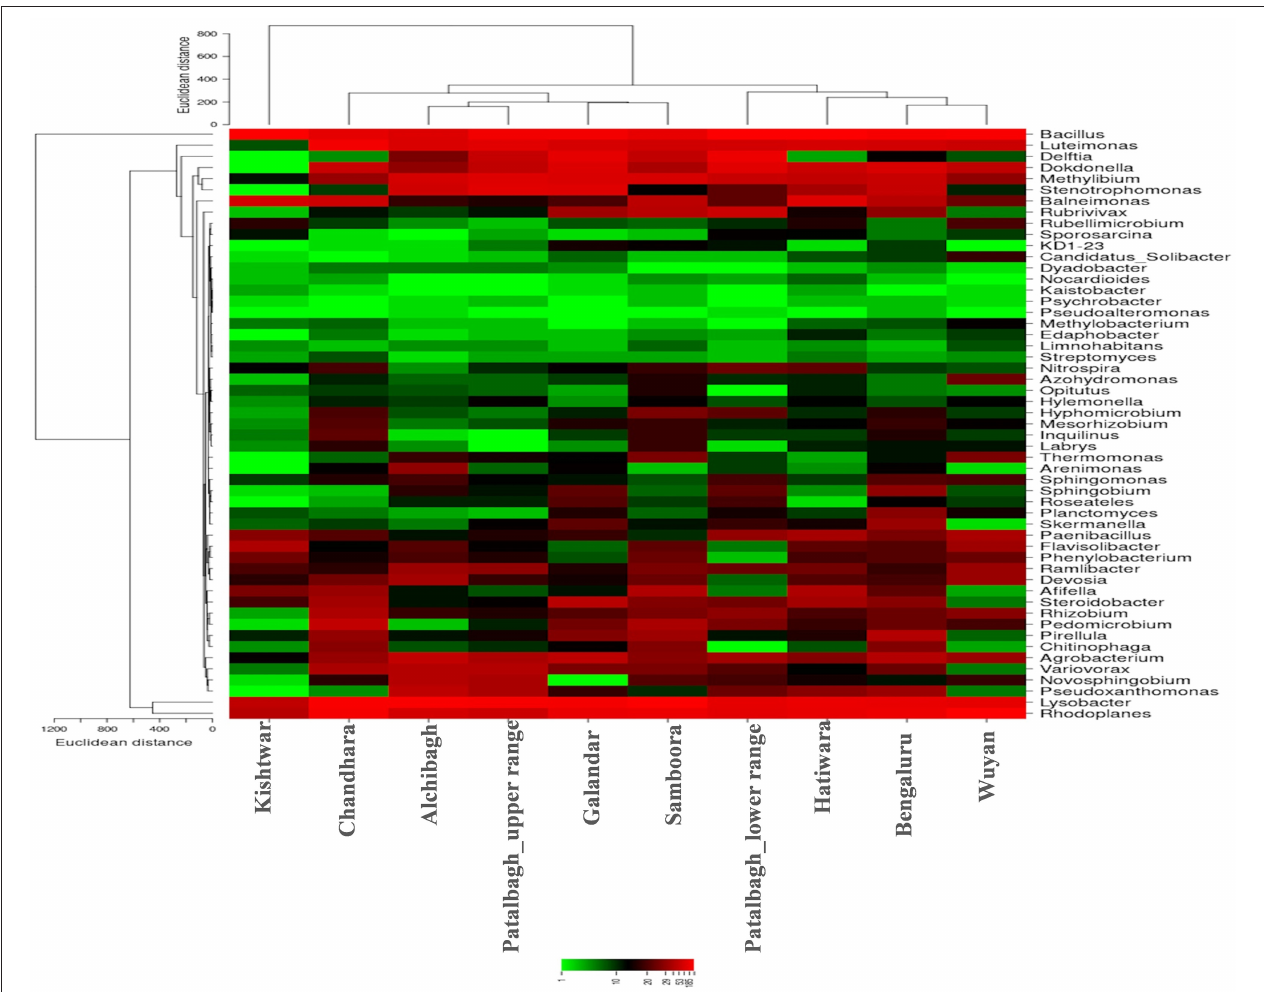
FIGURE 9 | Heat map representing the relative abundance of core genera (53) in the Saffron rhizosphere from 10 different samples. Saffron rhizo-bacteriome in Kishtwar was different than rest of the samples as represented by phylogenetic tree comparing all the